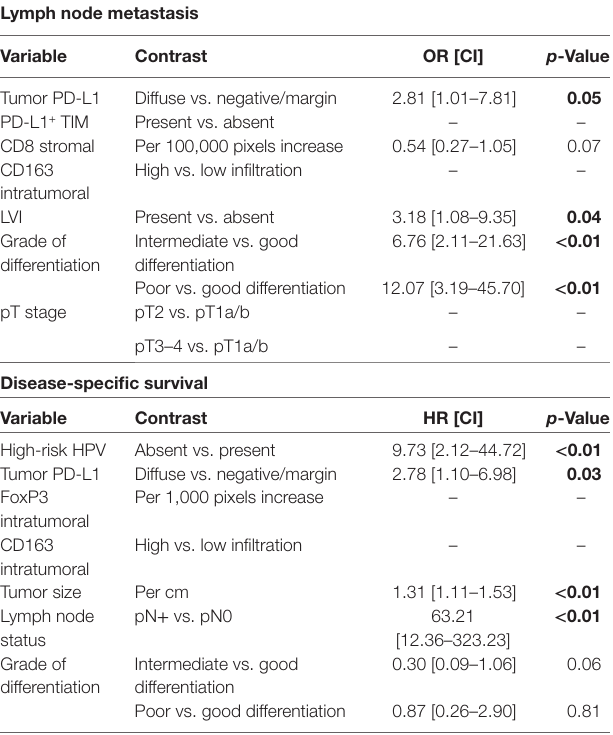
TaBle 3 | Multivariable backward regression analysis. lymph node